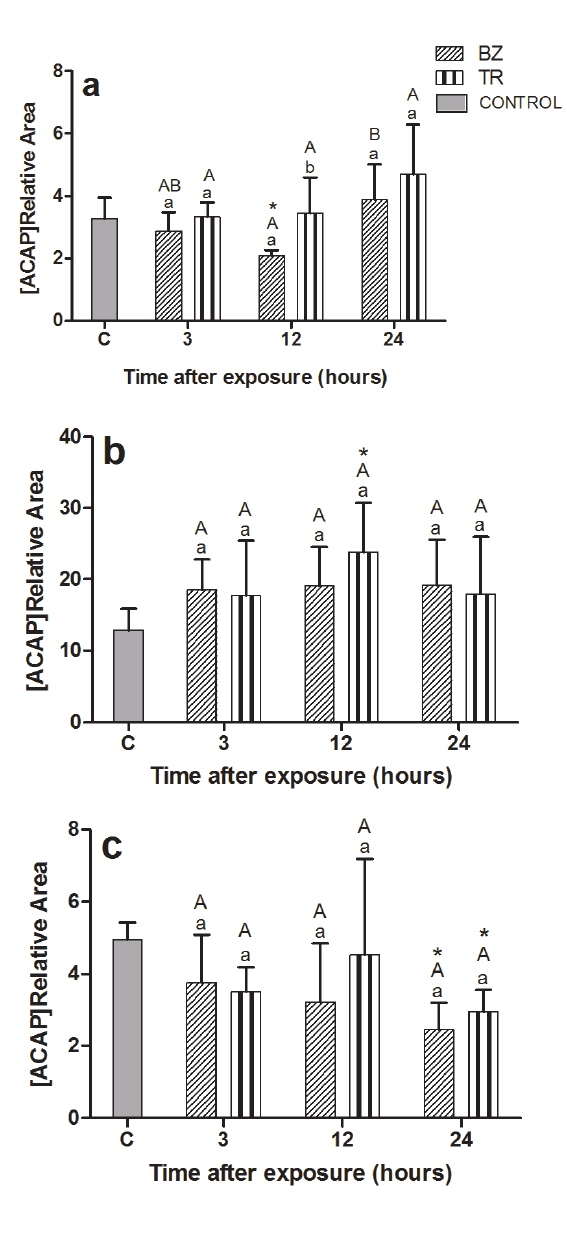
Figure 2 - Activity of the enzyme glutathione S-transferase (GST) of gills ( a ), liver ( b ) and brain ( c ) of juvenile tambaqui, Colossoma macropomum anesthetized with benzocaine or tricaine. Values are expressed as means ± SD. Different lowercase letters indicate significant differences between treatments (anesthetics) within sampling time; different capital letters indicate significant differences within treatment over time; asterisk indicates significantly different from control (C) (n = 10,